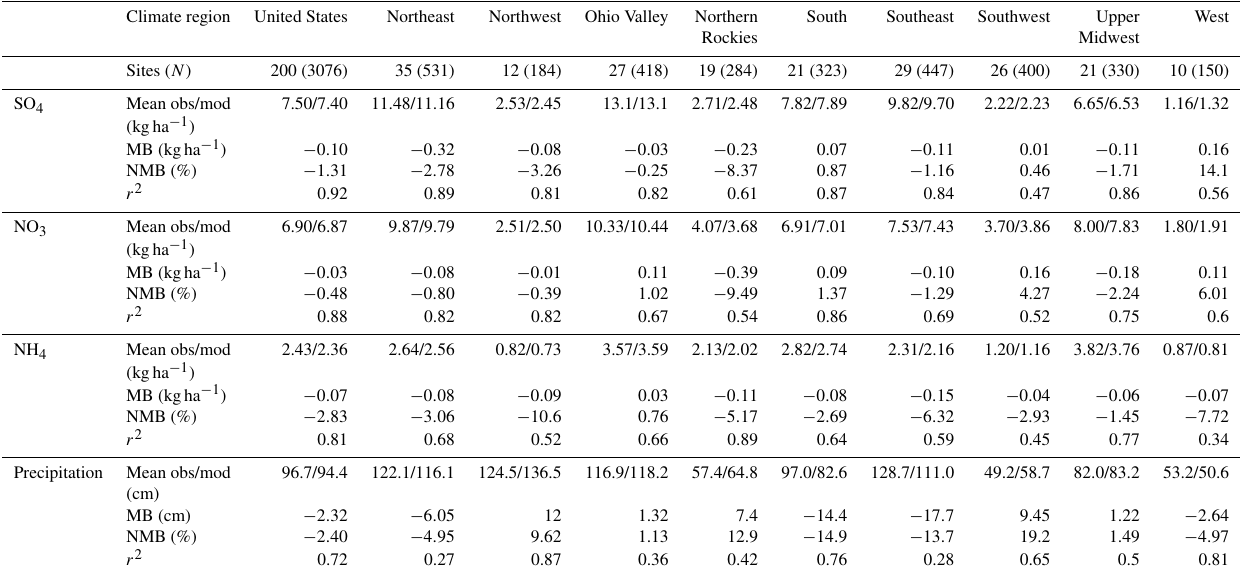
Table 2. Evaluation of bias-adjusted SO 4 , NO 3 , and NH 4 wet deposition and precipitation compared to NTN measurements in the contiguous US and nine climate regions that meet the completeness criteria (obs/mod: